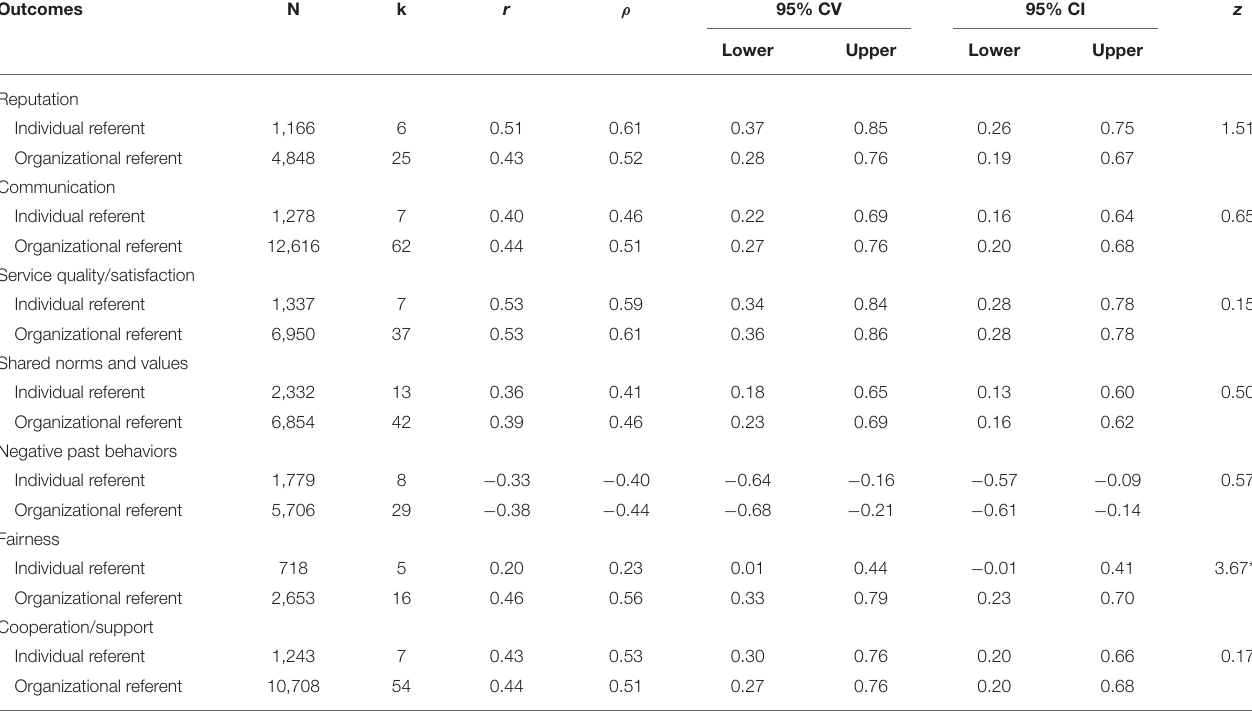
TABLE 5 | Moderator analysis of referents of trust and meta-analytic antecedents.